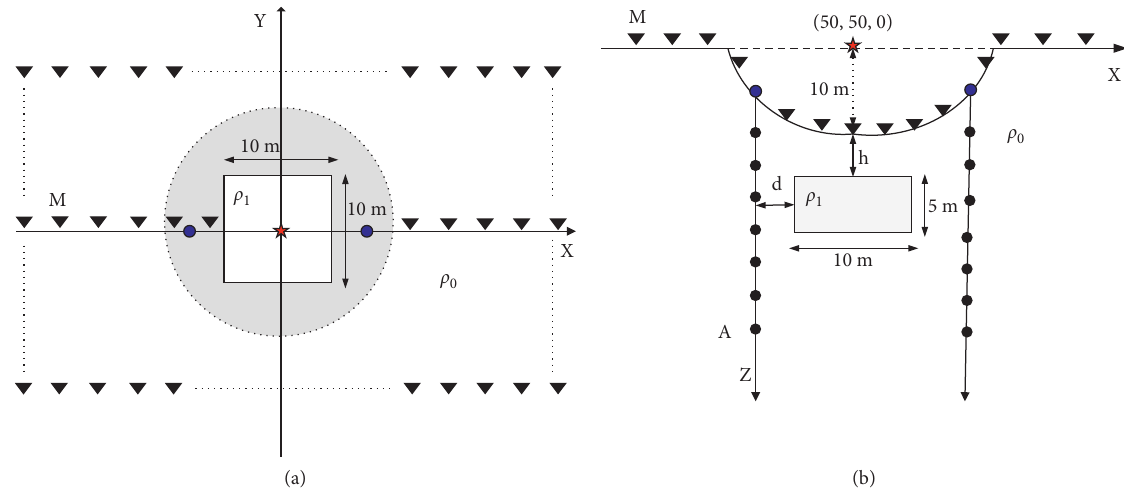
Figure 9: The geometry of valley topographical model with a cube. (a) XOY plane view; (b) XOZ cross-sectional view.